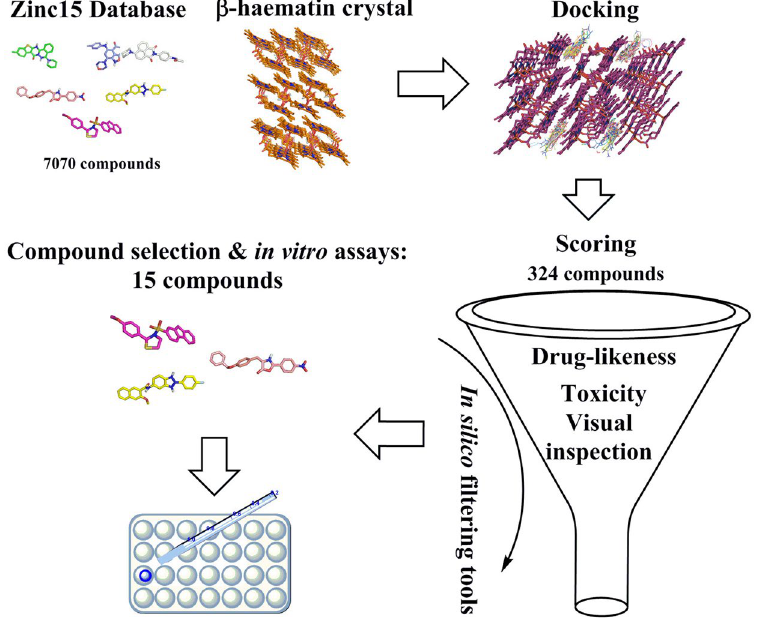
Figure 1. Schematic illustration of the VS protocol used in this investigation. Compounds for in silico docking were sourced from the ZINC15 database. Only those with suitable properties (logP < 5, MW < 425, reactivity clean and in stock) were considered. These were docked with a β -haematin crystal using the PyRx virtual screening tool. The top 324 hits were further filtered for drug-like properties using OSIRIS DataWarrior and 15 compounds purchased for experimental